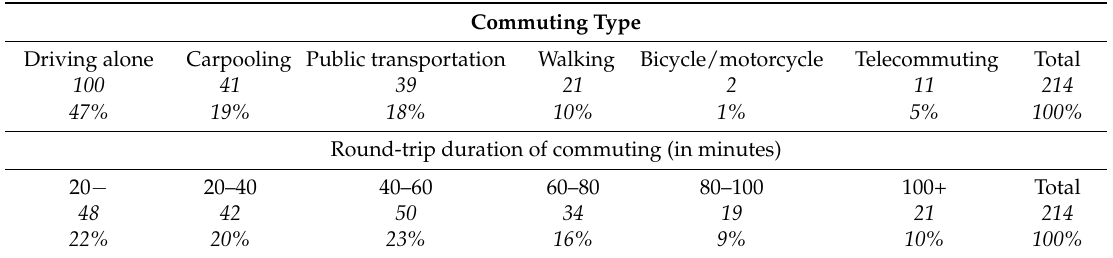
Table 3. How and how long participants usually commute ( regarding the last two years ) ( N:214